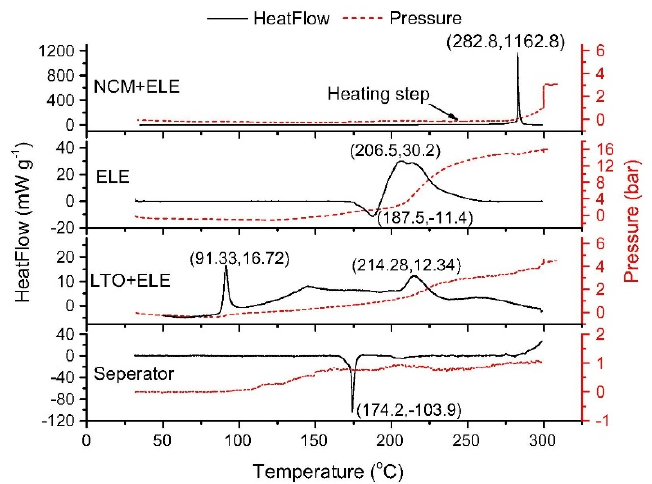
Figure 5. Heat flow vs temperature for the battery components of cathode, electrolyte, anode and separator [23].